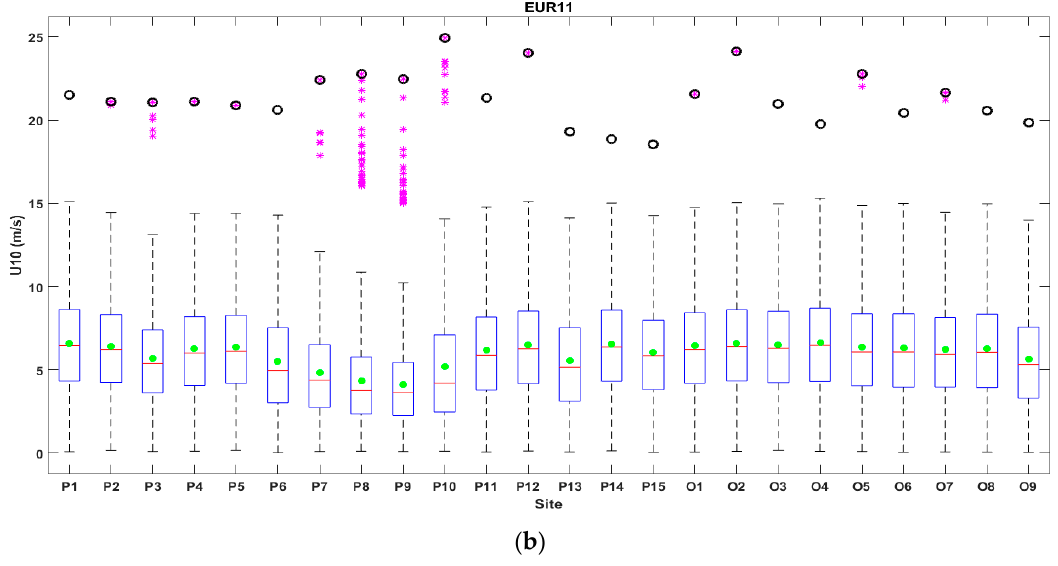
Figure 6. Box-and-whisker plots of U10 wind conditions in the sites considered, for NCEP ( a ) and EUR11 ( b ) The maximum value is market with black circle, while the extreme outliers are represented with magenta stars.